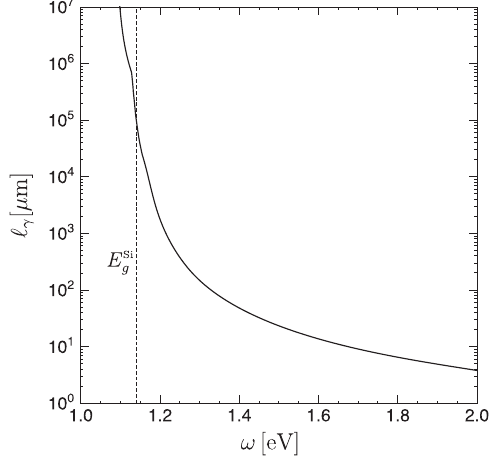
FIG. 15. Photon attenuation length in Si for energies close ¼ 1 . 14 eV, at the SENSEI opera- to the indirect Si band gap, E Si g ting temperature T ¼ 135 K. The data are taken from a fit in Ref. [173], which allows for single-phonon-assisted